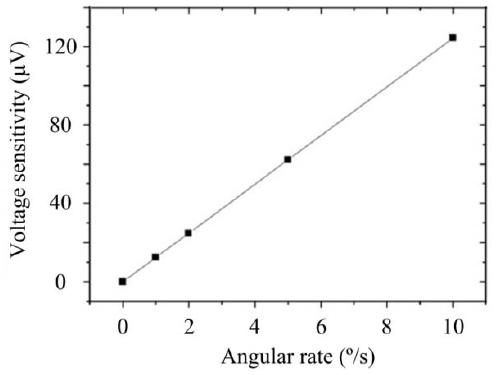
Figure 8. Simulation of voltage